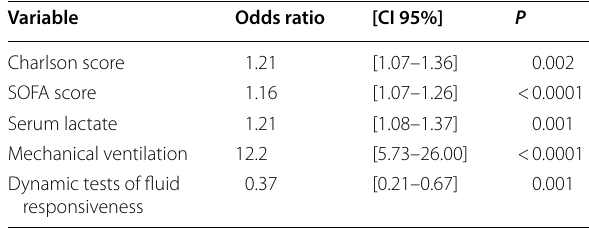
Table 4 Independent determinants of mortality according to logistic regression